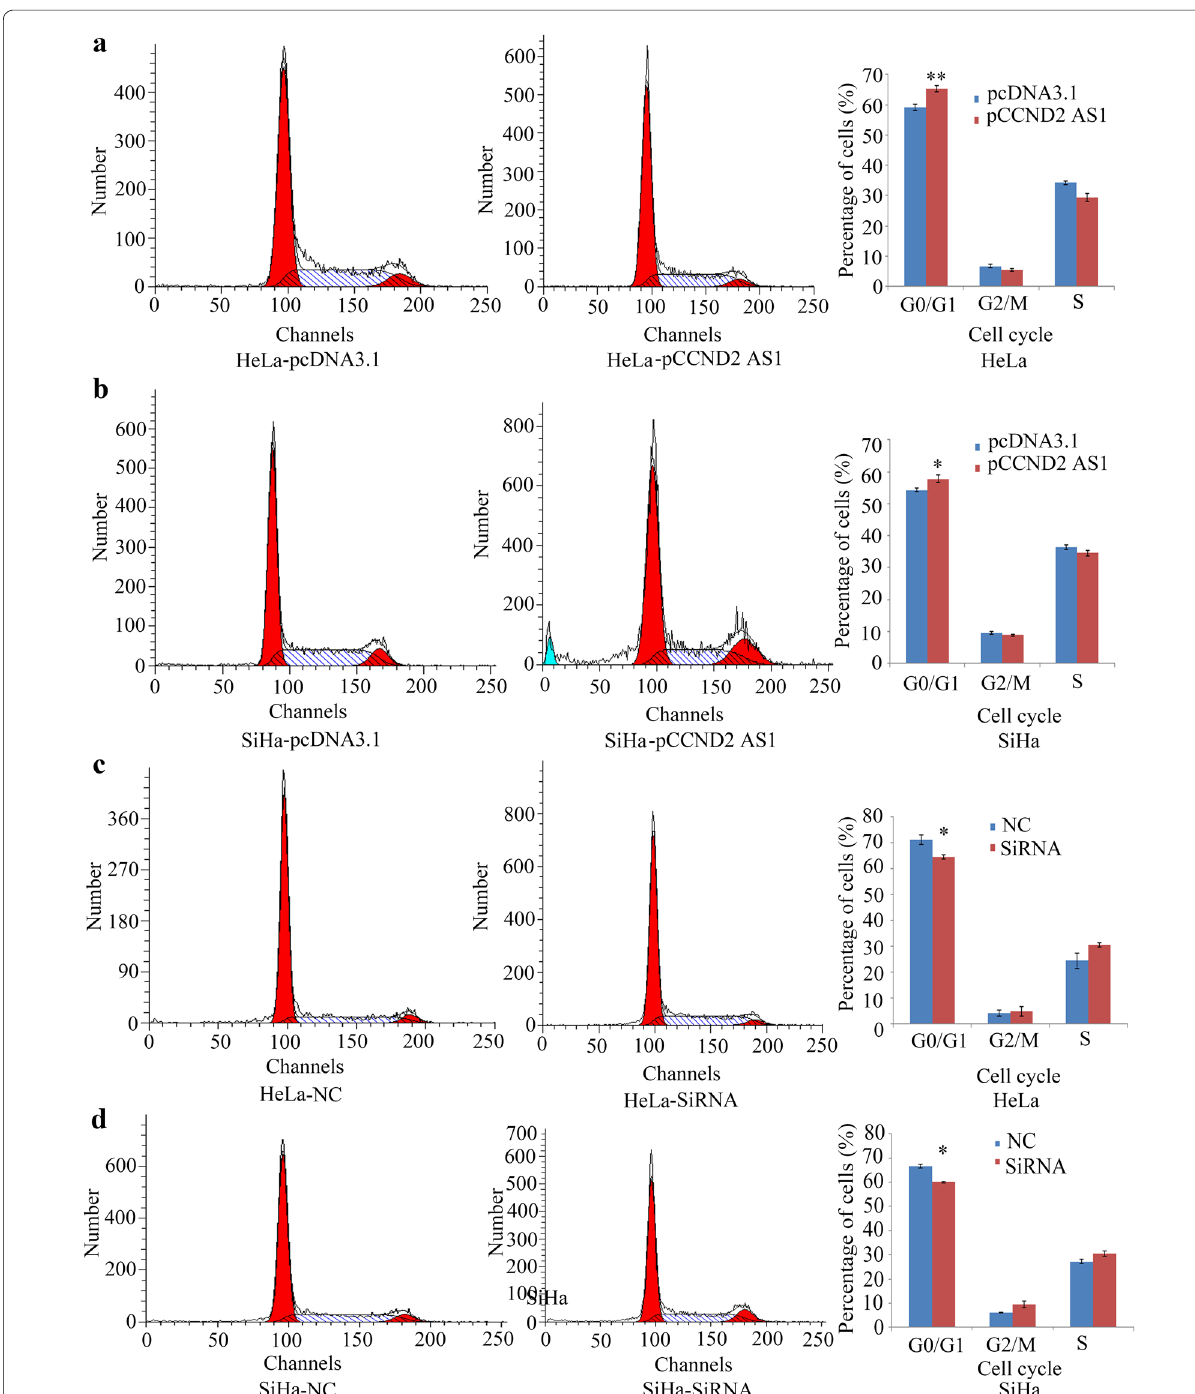
Fig. 3 CCND2 AS1 inhibits cell proliferation by arresting the cell cycle at the G1/S phase in cervical cancer cell lines. a , b The distribution of cell cycle phases analysis by flow cytometry between enforced expression of pCCND2 AS1 and control (pcDNA3.1) in HeLa and SiHa cell lines. The percentages of cells in the G1, S, and G2/M phases are shown in the bar chart as the mean ** p < 0.01. c , d Flow cytometry analysis of the distribution of cell cycle phases in negative control (NC) and CCND2 AS1 SiRNA2 in HeLa and SiHa cell lines. The percentages of cells in the G1, S, and G2/M phases are shown in the bar chart as the mean * p <